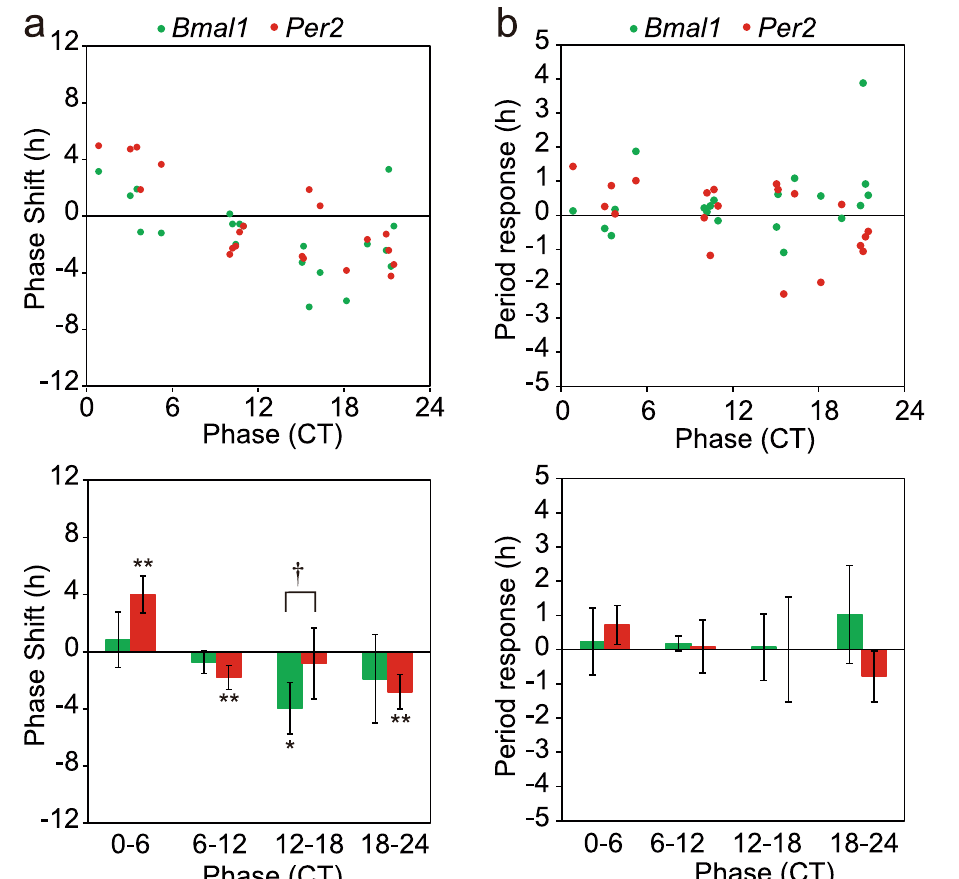
Figure 6. Phase-response curve and period-response curve for medium exchange of circadian Bmal1 and Per2 rhythms in the adult SCN ( a ) Phase-responses in individual slices (n = 20) of circadian Bmal1 (green circle) and Per2 (red circle) rhythms in the adult SCN (upper). The SCN was pretreated with distilled water (see text). Mean phase-shifts with SD at CT0–CT6 (n = 5), CT6–CT12 (n = 4), CT12–CT18 (n = 5) and CT18–CT20 (n = 6) (lower). See also the legend for Fig. 4a. A significant phase-shift is indicated with asterisk ( * ). * p < 0.05, ** p < 0.01, and a significant difference in the response between the two circadian rhythms is shown with dagger ( † ). † p < 0.05. ( b ) Period-responses obtained from the same experiment as ( a ). Period-responses in individual slices of circadian Bmal1 (green circle) and Per2 (red circle) (upper), and the mean responses with SD at the 4 circadian phases